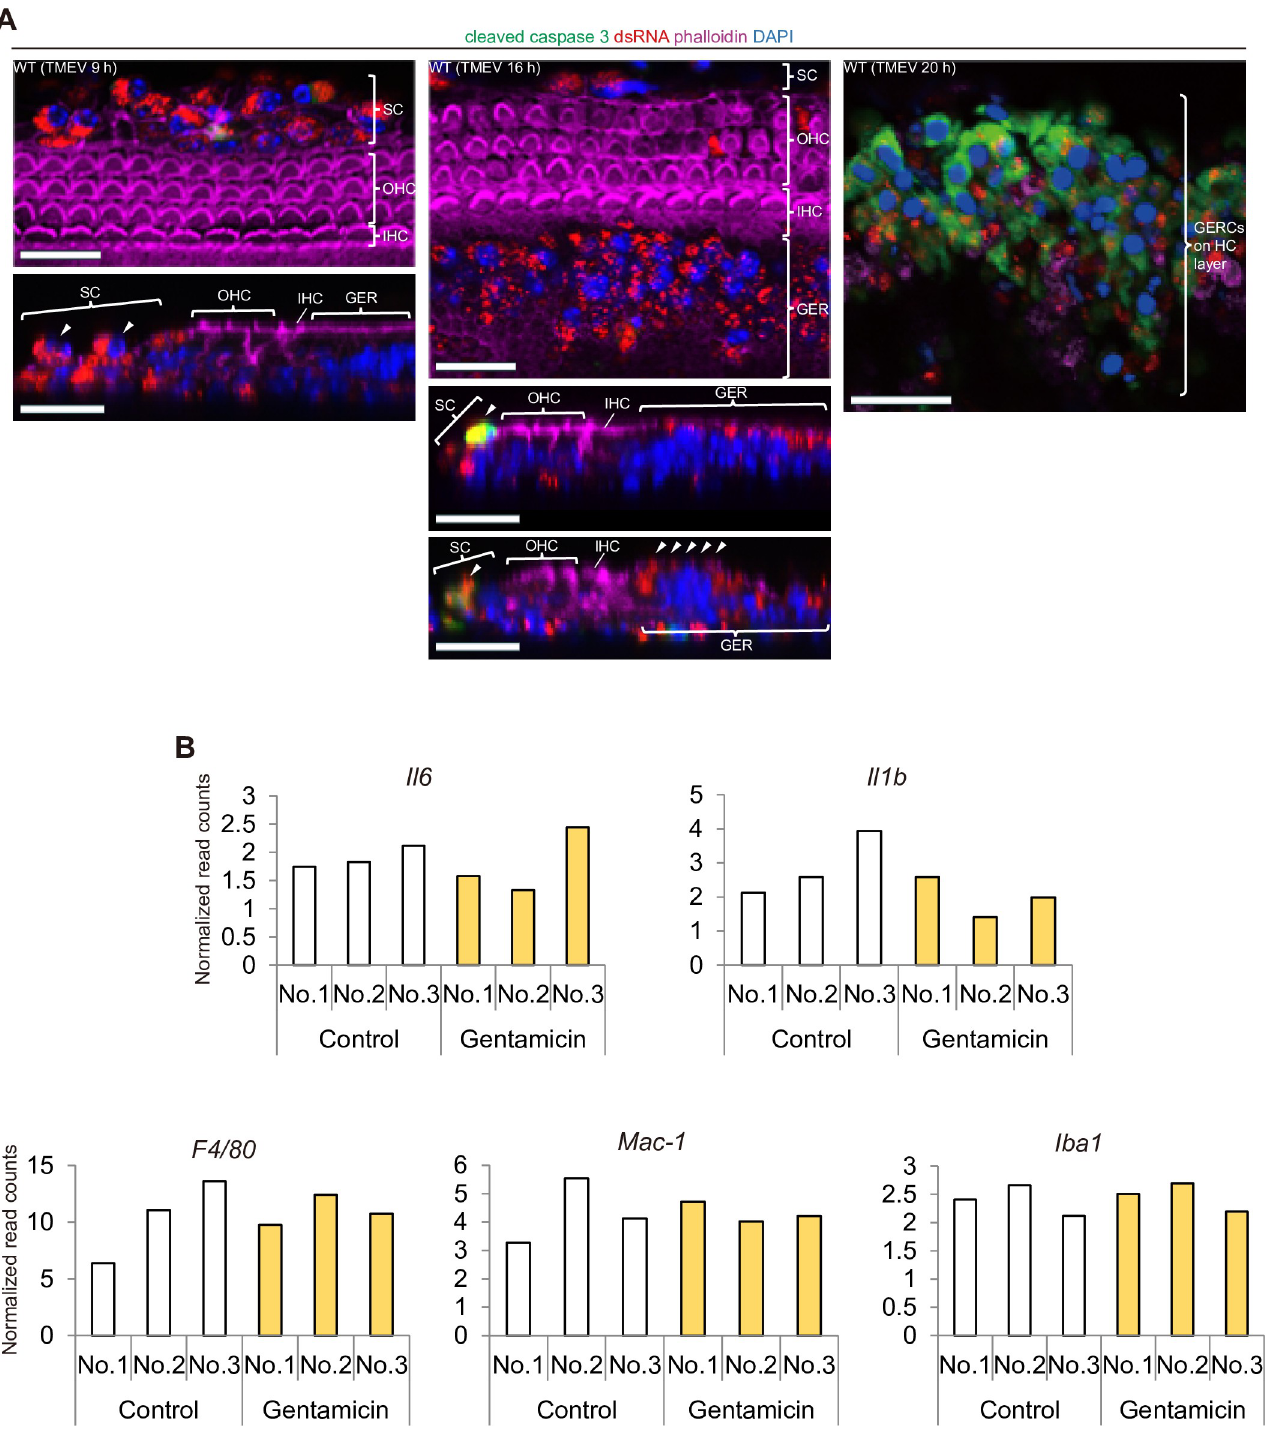
Fig 3. Virus-infected SC- and GERC-induced HC death is not mediated by apoptosis. ( A ) Cleaved caspase 3 (green) was expressed in TMEV-infected SCs and GERCs (arrowheads in sections), but not in HCs, which indicated that apoptosis did not occur in HCs. At 20 h after infection (right panel), most SCs had died by apoptosis and infected GERCs had migrated onto the HC layer, as described previously [12]. ( B ) Tao et al. deposited RNA sequence datasets for sorted HCs (GFP positive) and surrounding cells including SCs (GFP-negative non-HCs) from explant cultures of an Atoh1-GFP organ of Corti treated with gentamicin for 3 h in the NCBI GEO database (GSE66775) [38]. In this database, we focused on macrophage- and inflammation-correlated gene expression changes in a non-HC population including SCs to compare virus infection with aminoglycoside-related injury. Here, we extracted inflammation markers Il6 and